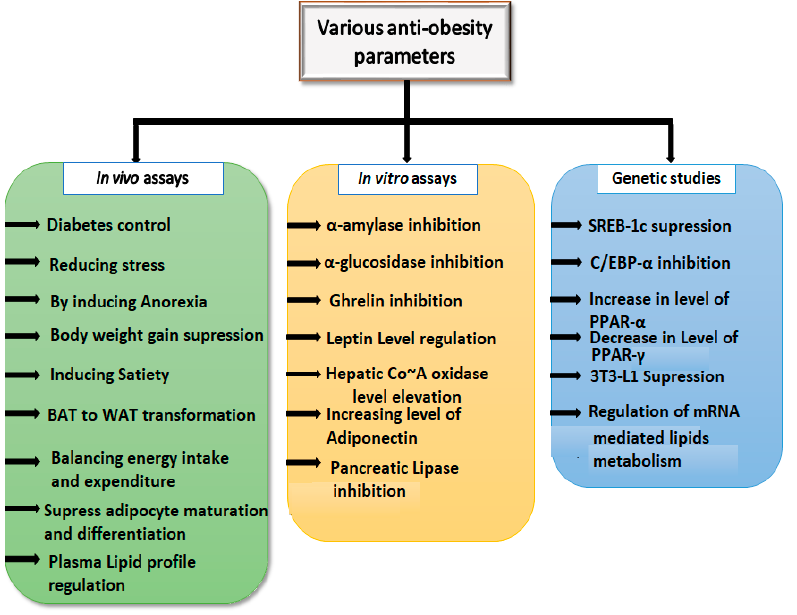
Figure 2. List of various parameters for assessing the anti-obesity efficacy of various natural